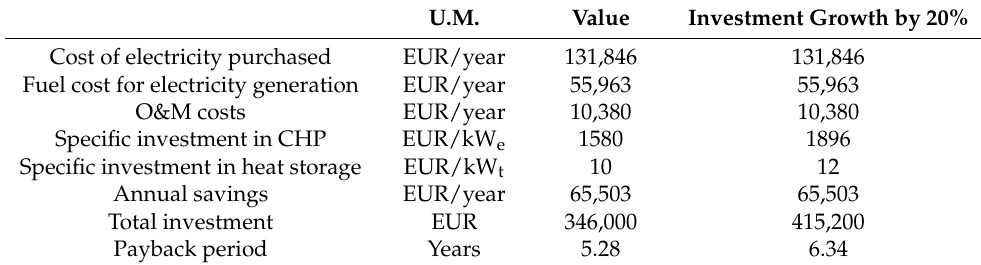
Table 6. Cogeneration (2 × 100 kW e , 2 × 130 kW t ) and heat storage: summary results. U.M.